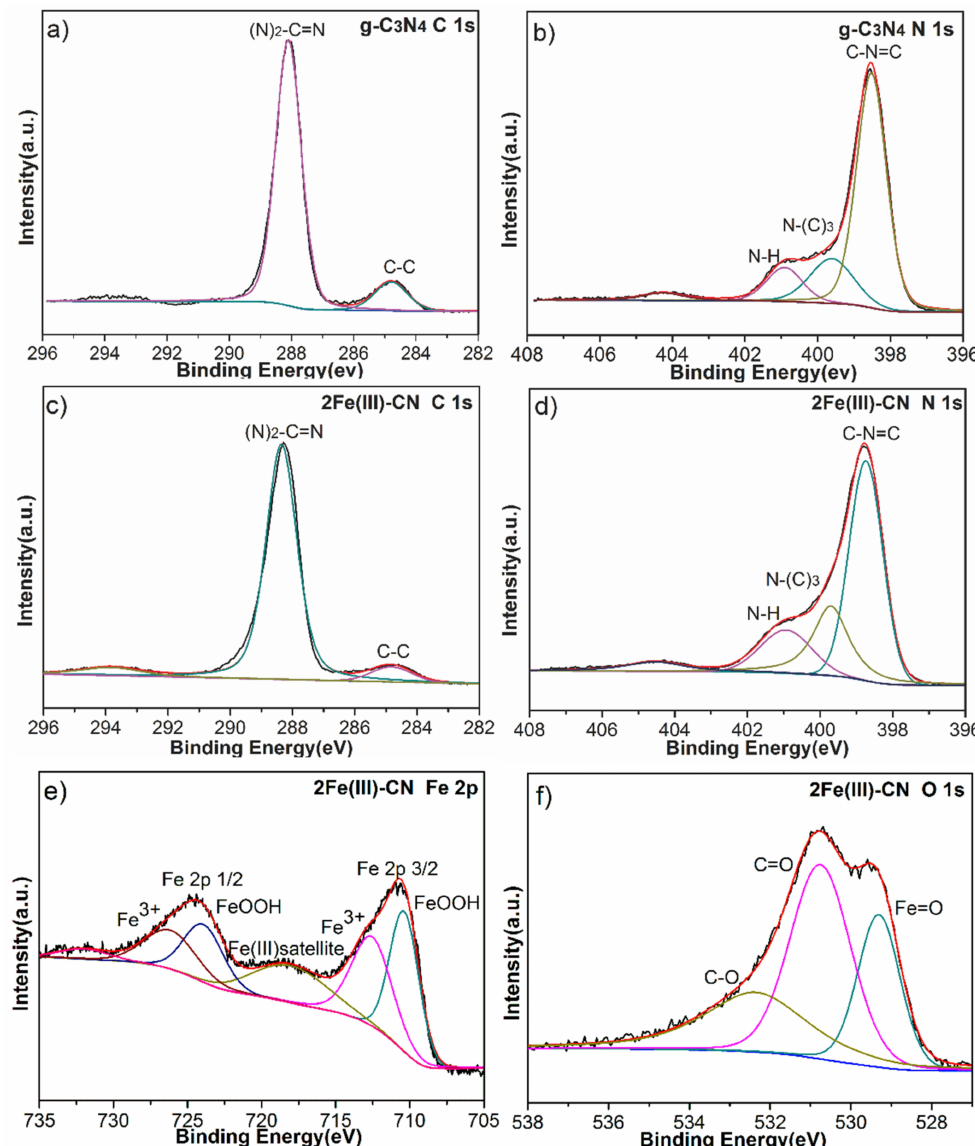
Figure 6. C 1s ( a ) and N 1s ( b ) XPS spectra of g-C 3 N 4 ; C 1s ( c ), N 1s ( d ), Fe 2p ( e ) and O 1s ( f ) XPS spectra of 2Fe( Ш )-CN